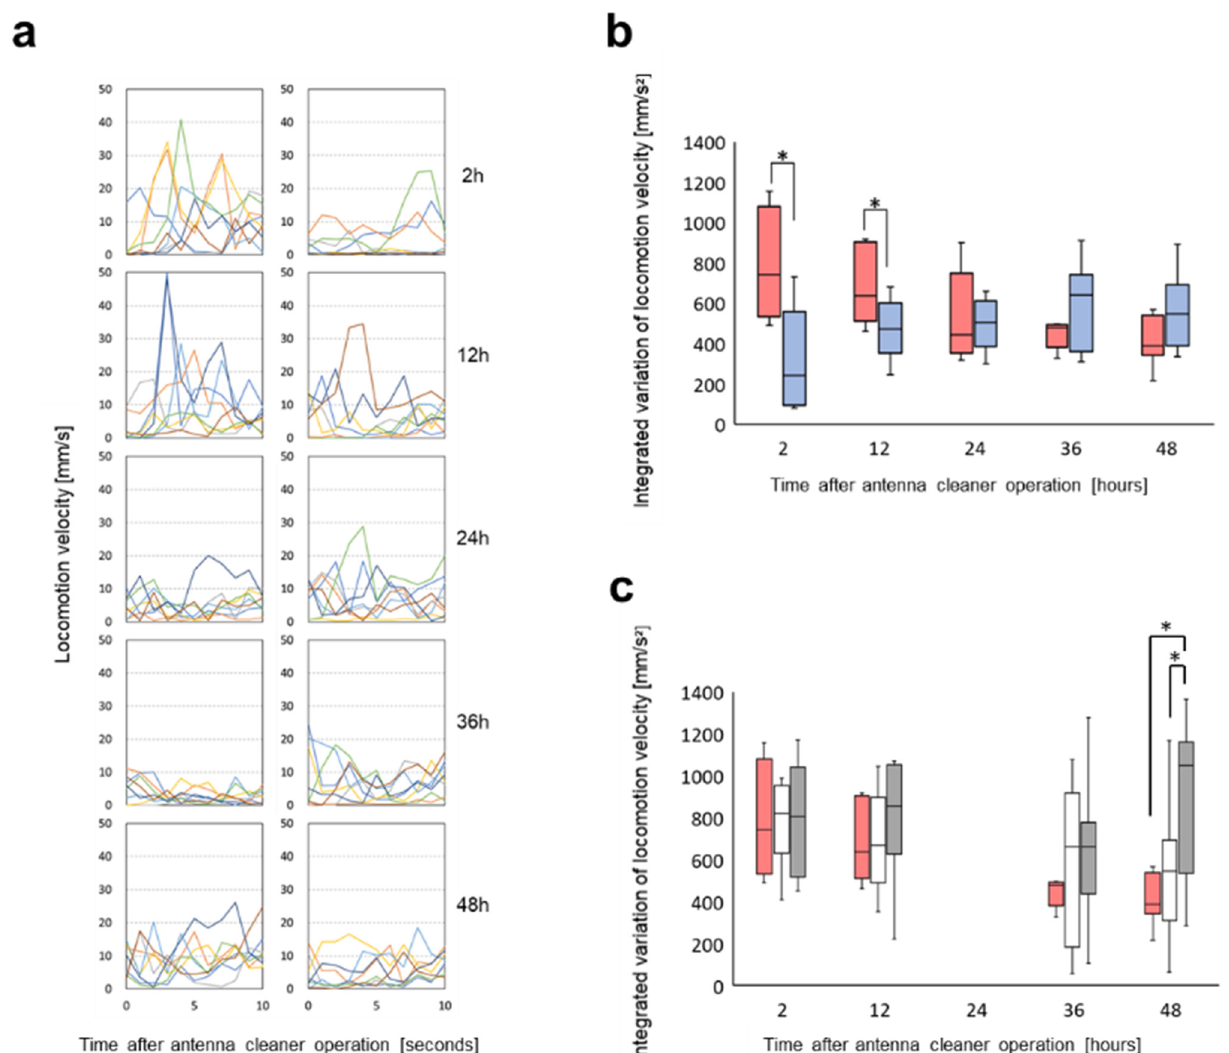
Figure 3. Locomotion velocity changes in the presence of undecane and/or n -hexane. ( a ) Locomotion velocity changes in the presence of odor of undecane diluted in n -hexane (left) or plain n -hexane (right) at 2, 12, 24, 36, and 48 h after the antenna cleaner removal operation (top to bottom). Different colored lines show locomotion velocity changes of eight test ants during 10 s from the beginning of odor exposure. ( b ) The integrated variations of ants’ locomotion velocities are plotted against time after the antenna cleaner removal operation. Red and blue columns indicate the integrated variations of ants’ locomotion velocities in the presence of undecane diluted in n -hexane and plain n -hexane, respectively. ( c ) Red columns are the same as those in ( b ), but white and gray columns indicate the integrated variations of sham-operated ants’ locomotion velocities in the presence of undecane diluted in n -hexane and of plain n -hexane, respectively. Asterisks indicate significant difference (Wilcoxon signed rank test, p < 0.05, n = 8).